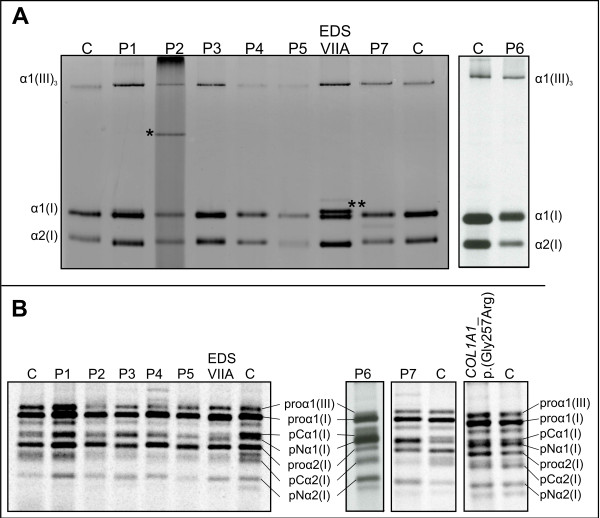
SDS-PAGE analysis of secreted 14C-labeled (pro)collagen molecules from dermal fibroblasts. Secreted procollagen molecules were extracted from the medium fraction of the cell cultures. The globular N- and C-propeptide of the procollagen molecules were removed by pepsin-digestion, resulting in mature triple helical collagen proteins. Lane numbers correspond to the patient’s numbers in the text; “C” corresponds to control samples. panel A: medium fraction. P2: note the extra band of higher molecular weight, suggestive for presence of mutant α1(I)-collagen dimers ( indicated by *). EDS VIIA: patient with EDS arthrochalasis type, due to a COL1A1 exon 6 skip: note the “doublet” for the α1(I) collagen chain that corresponds to mature α-chains and the incompletely cleaved pNα1(I)-chains (indicated by **) respectively. This doublet is absent in the OI/EDS patients. panel B: medium procollagen fraction. Compared to the control sample, the intensity of the bands representing the pNα1(I) chain is increased, whereas the intensity of the bands representing the pCα1(I) and the mature α1(I)-chain is decreased. This is caused by a disturbed balance in the normal kinetics of the delayed N-processing and the unhampered C-processing of type I procollagen. This pattern is similar to what is observed in the patient with EDS arthrochalasis type (EDS VIIA). In the right panel, the medium procollagen fraction is shown from a patient with classic OI, without EDS-signs, with p.(Gly257Arg) substitution in exon 11 of COL1A1. Here, intensity of the bands representing the pNα1-, pCα1- and mature α1 chains of type I collagens is comparable to that of the control.